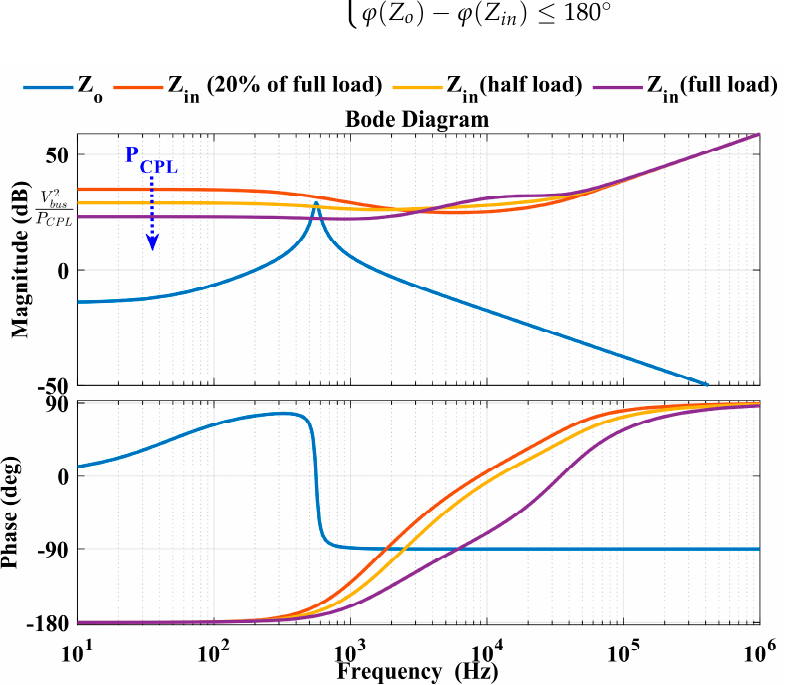
Figure 4. Bode diagram of Z in ( s ) and Z o ( s ) with different loading